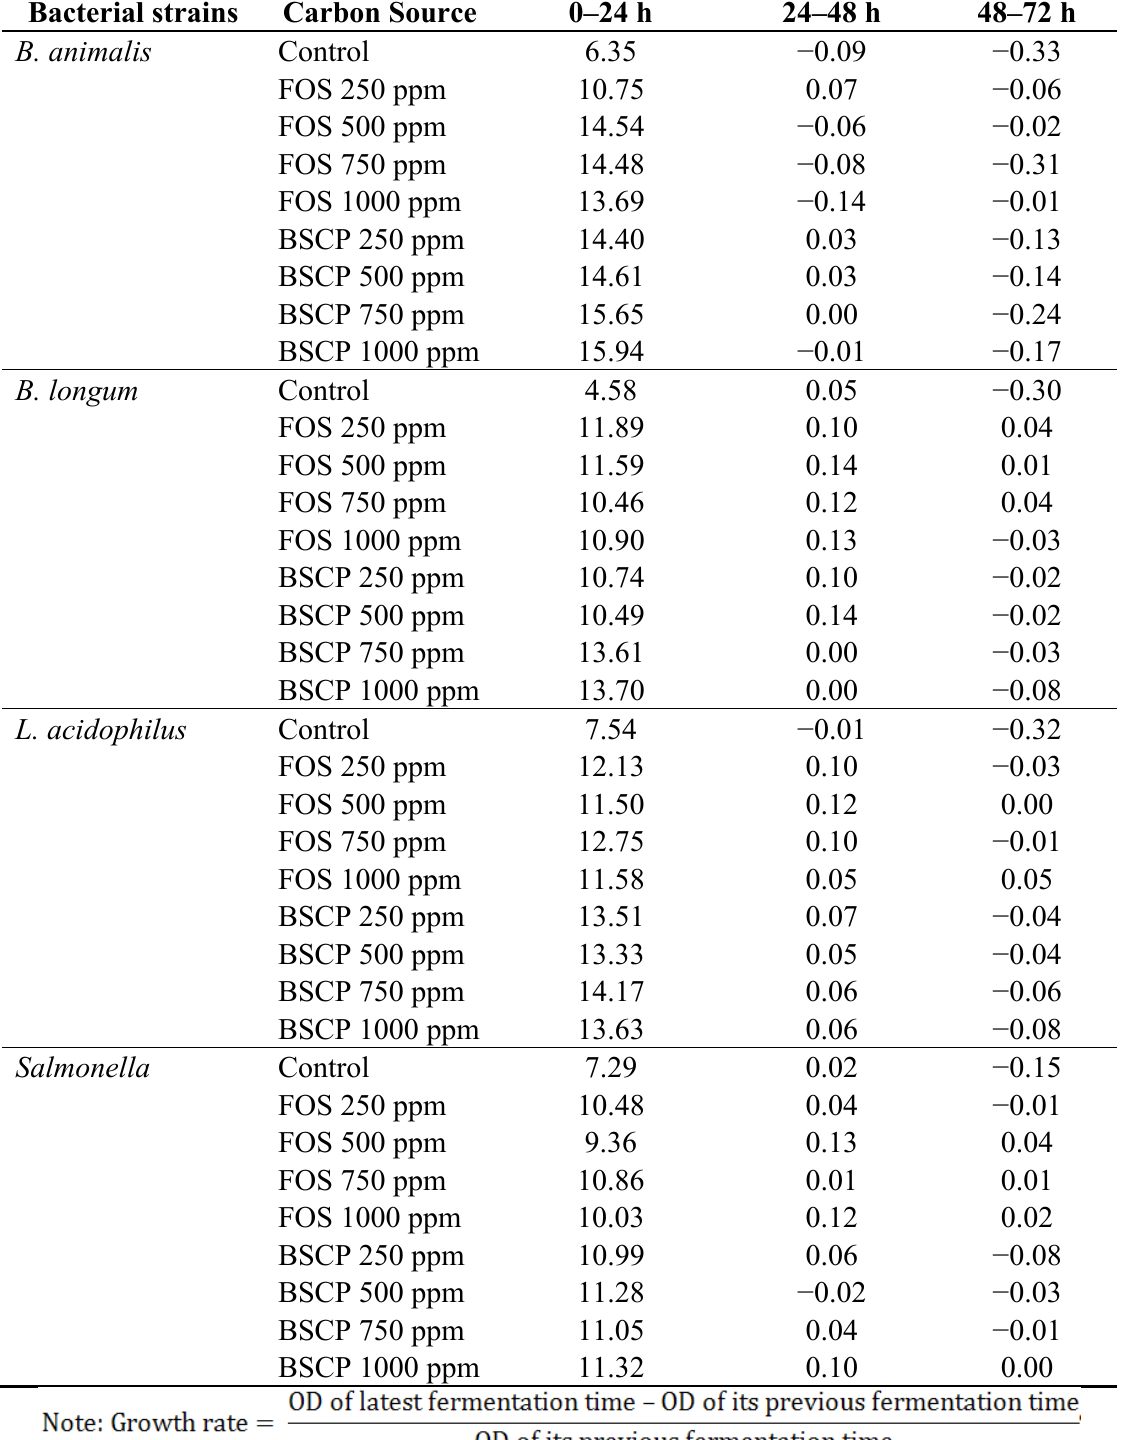
Table 2. The growth rate* of selected probiotics and Salmonella over fermentation time as supplemented with different concentration of FOS and